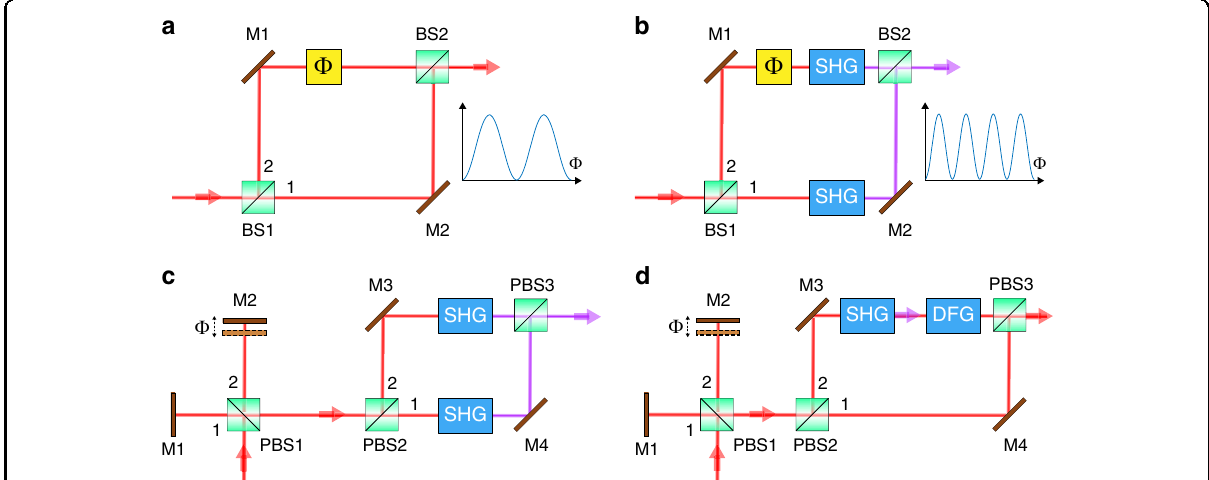
Fig. 1 Schematics of the interferometer con fi gurations. a MZI. b Nonlinear MZI. c Nonlinear polarized interferometer. d Con fi guration for phase doubling without frequency